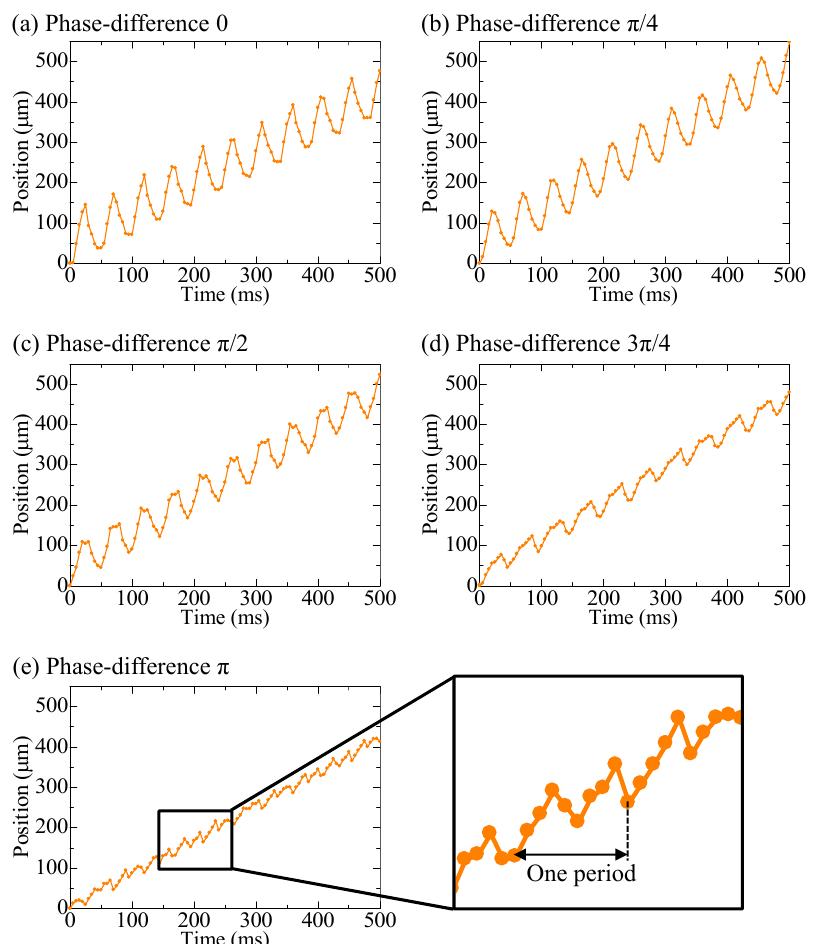
Figure 7. Bead positions when driving a parallel pump, where ( a – e ) show the phase differences of 0, π /4, π /2, 3 π /4, and π , respecticely, and the enlarged graph shows one period at the phase difference of π , which was the condition for minimum